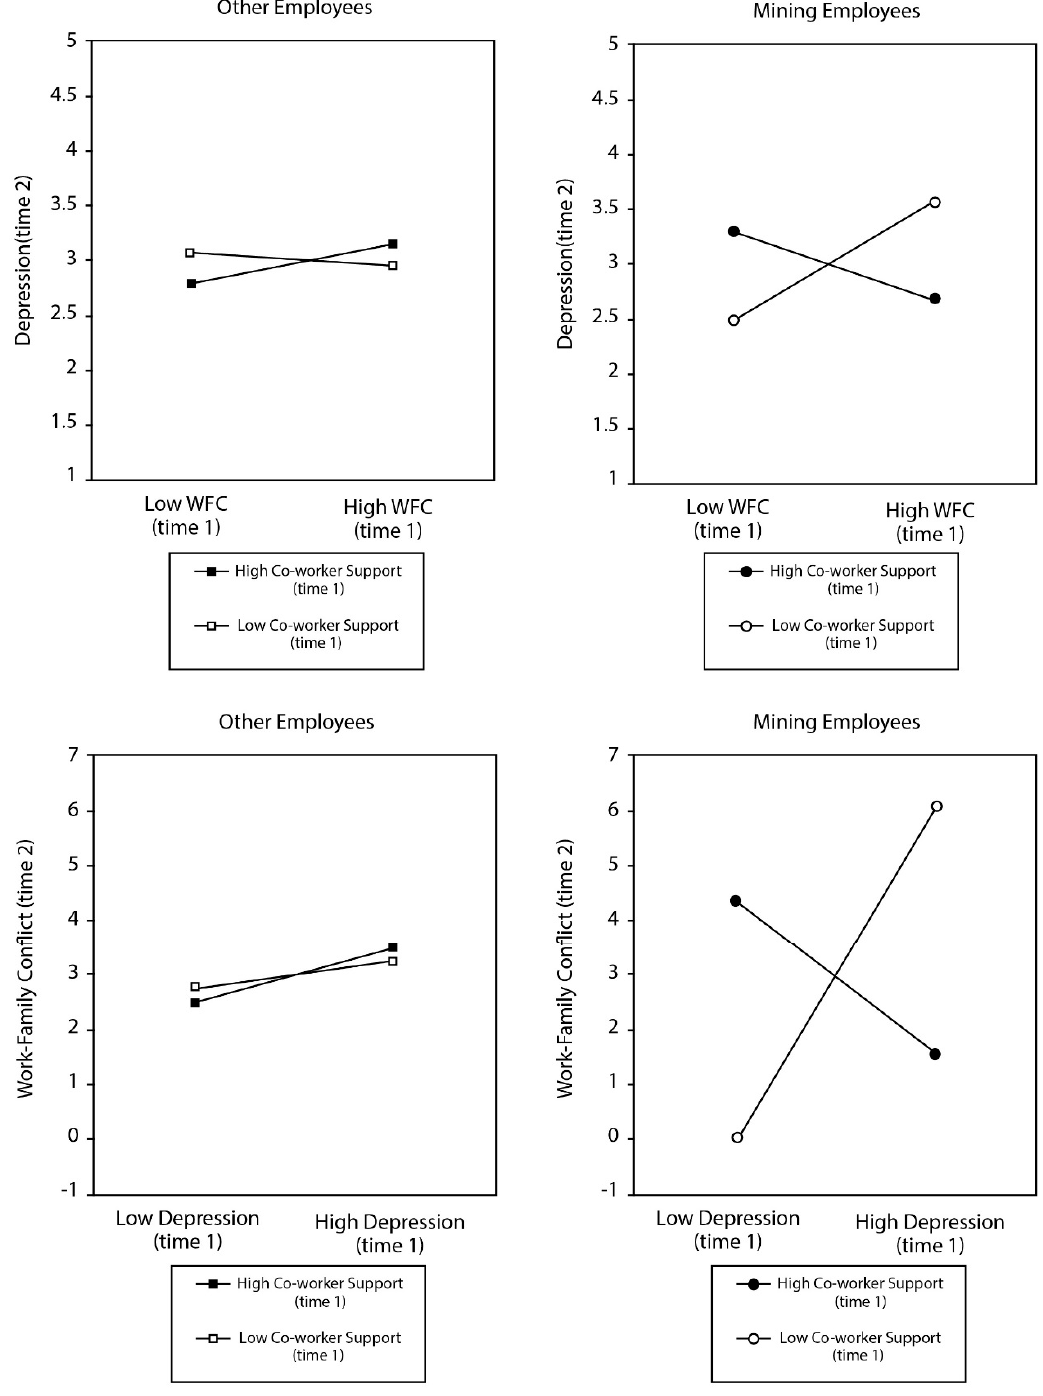
Figure 2. Interaction terms for the moderating effect of co-worker support on the work-family conflict depressive loss spiral in mining and a general work sample in Australia. WFC = Work-Family Conflict.